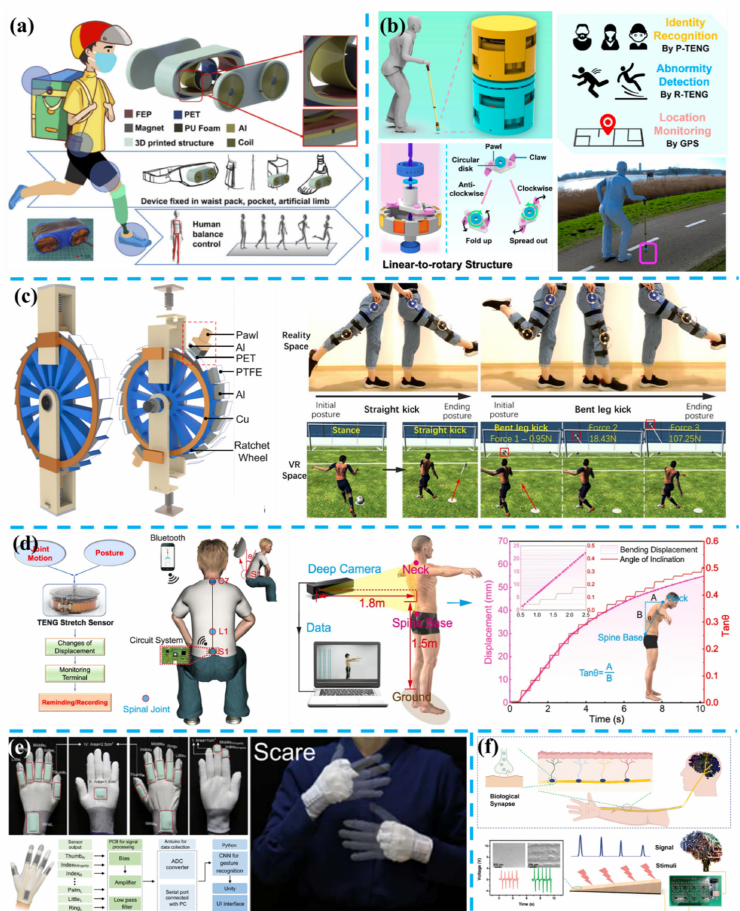
Figure 6. Human monitoring. ( a ) A hybrid biomechanical energy harvester designed for human balance control processes (Reprinted with permission from ref. [238]. Copyright 2021